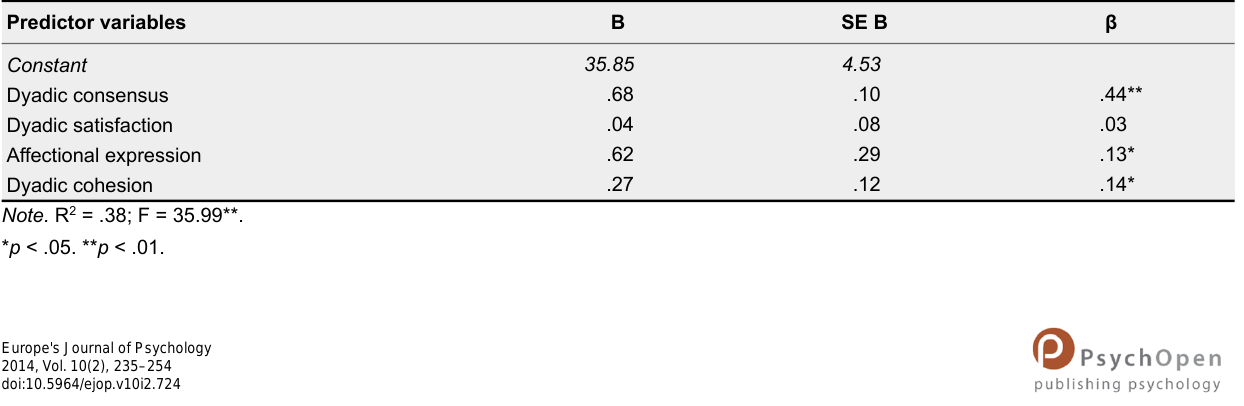
Predictors of Parenting Alliance in Mothers (N =